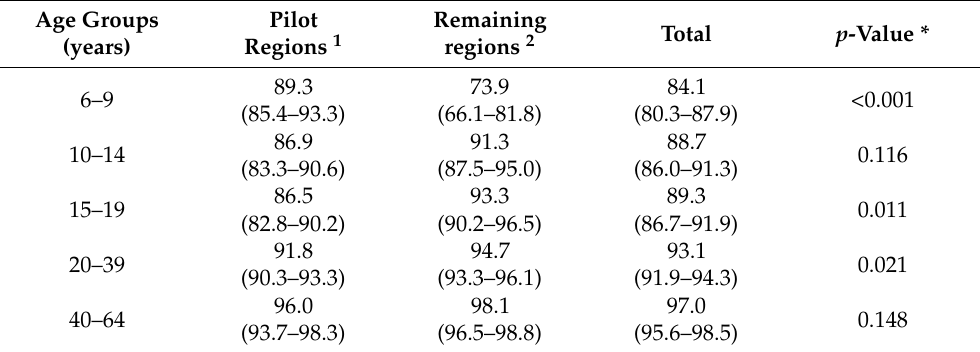
Table 4. Seroprevalence (%) and relative 95% CI by age group recorded in the pilot regions and in the regions that started varicella vaccination from the cohort of those born in 2016.